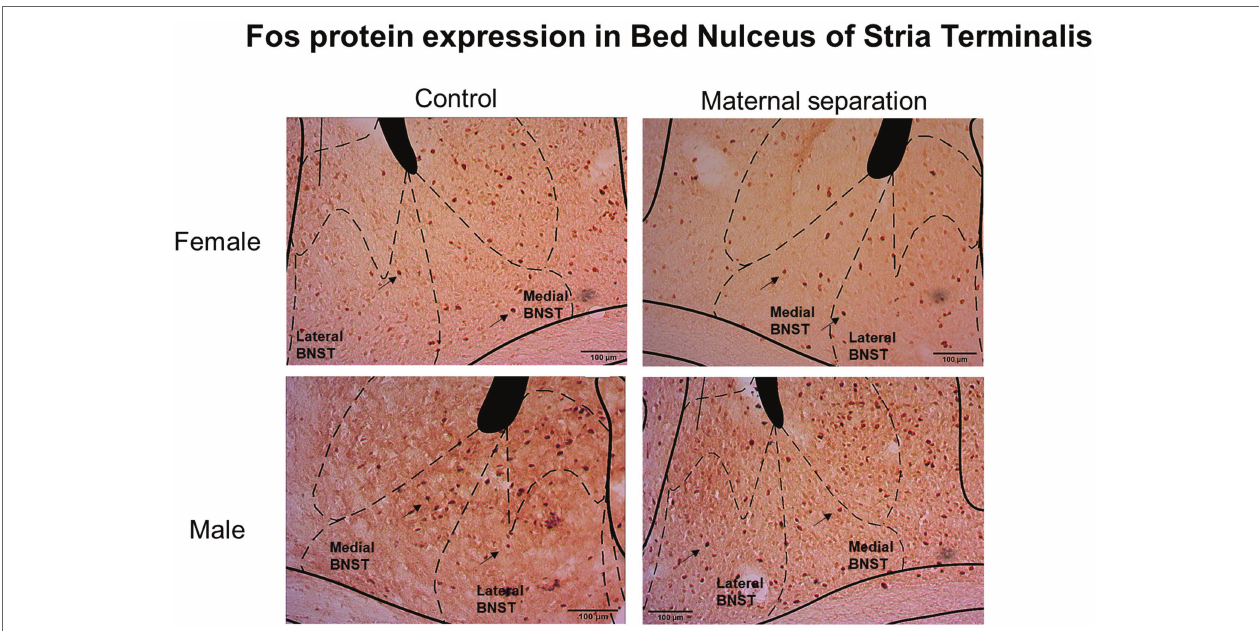
FIGURE 7 | Fos protein expression in medial and lateral bed nucleus of stria terminalis (BNST). Images represent Fos positive cells in medial and lateral BNST of female and male mice submitted to MS and control group. Black arrows indicate Fos-IR neurons. Coordinates for BNST: 0.14 mm anterior to bregma (Paxinos and Franklin,